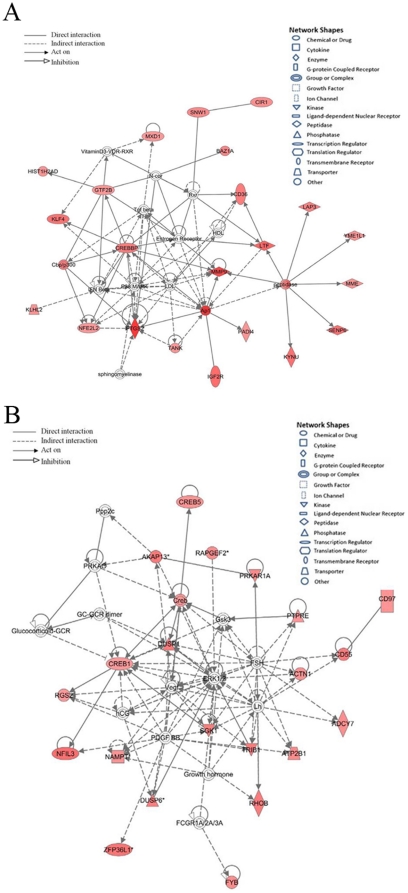
Most significant two gene networks of over-expressed genes in GBS patients.(A) Gene network involved in cardiovascular disease, hematological disease, neurological Disease; (B) gene network involved in amino acid metabolism, post-translational modification, small molecule biochemistry. Red: up-regulated in GBS compared to control. The intensity of the node color indicated the degree of up-regulation. Genes in uncolored notes were not identified as differentially expressed in our experiment and were integrated into the computationally generated networks on the basis of the evidence stored in the IPA knowledge memory indicating a relevance to this network.